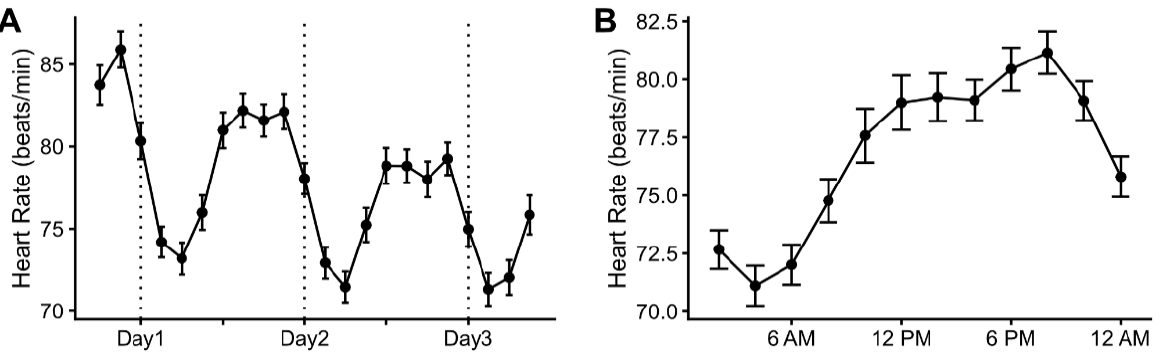
Figure 1. Heart rate changes in hemodialysis patients during the long interdialytic period. ( A ) Entire long interdialytic period. ( B ) Diurnal changes in heart rates. Heart rates are presented as means and standard errors in three-hour intervals.